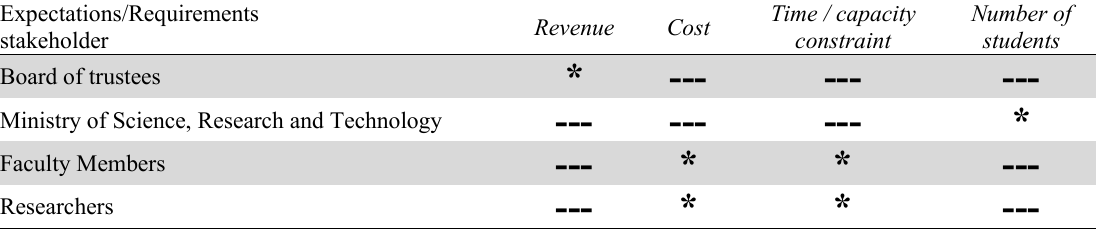
Four key stakeholders' expectations and